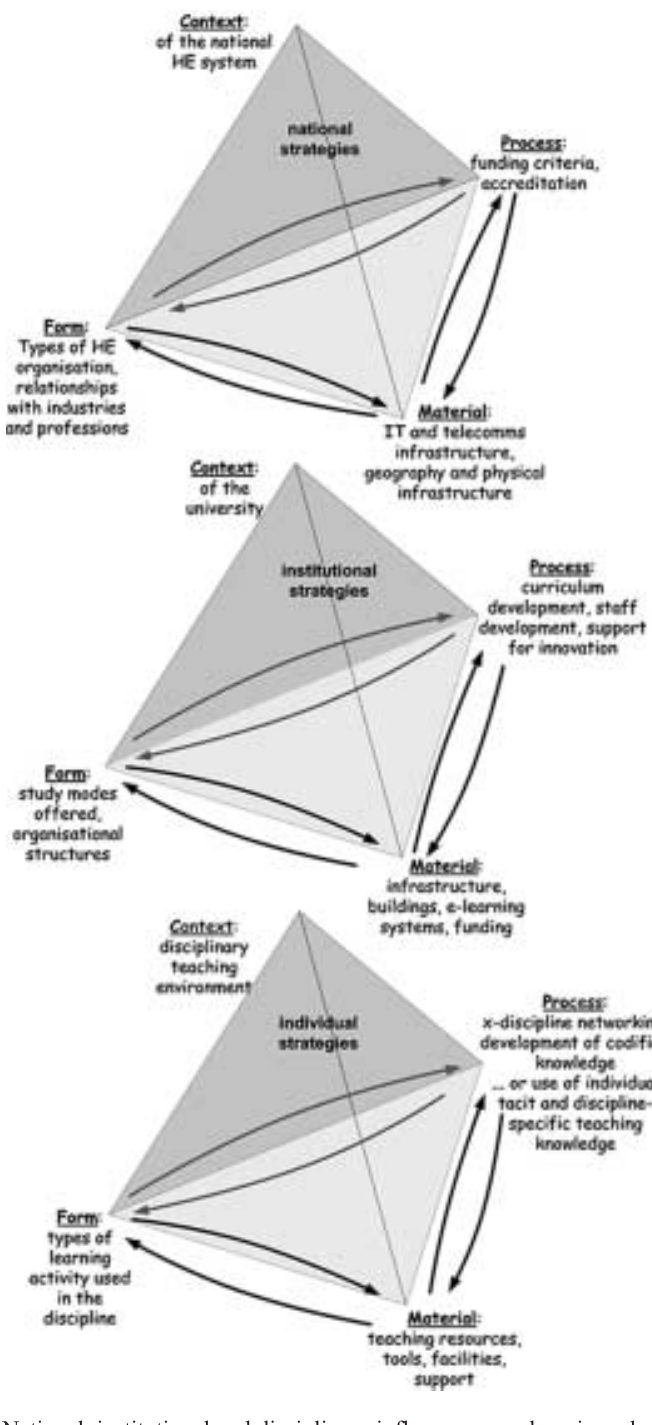
Figure 6. National, institutional and disciplinary influences on e-learning